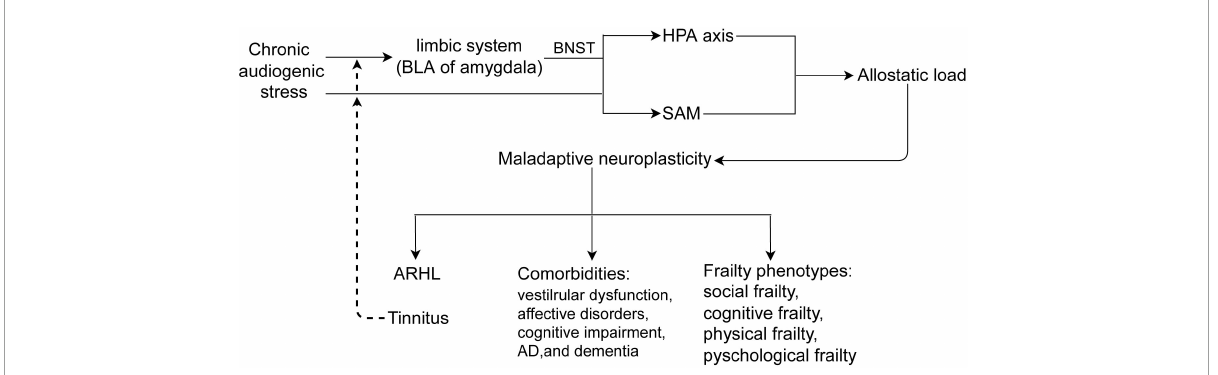
FIGURE3 Chronic audiogenic stress activates HPA axis by limbic system-BNST and SAM, induces allostatic load, which causes maladaptive neuroplasticity that contributes to ARHL and/or tinnitus, comorbidities, and frailty phenotypes. Tinnitus, a internal audiogenic stressor, could further activates HPA axis and SAM in a vicious circle. BLA, the basolateral nucleus of amygdala; BNST, the bed nucleus of stria terminalis; HPA, hypothalamus -pituitary-adrenal axis; SAM, sympathetic adrenal–medullary axis; ARHL, age-related hearing loss.